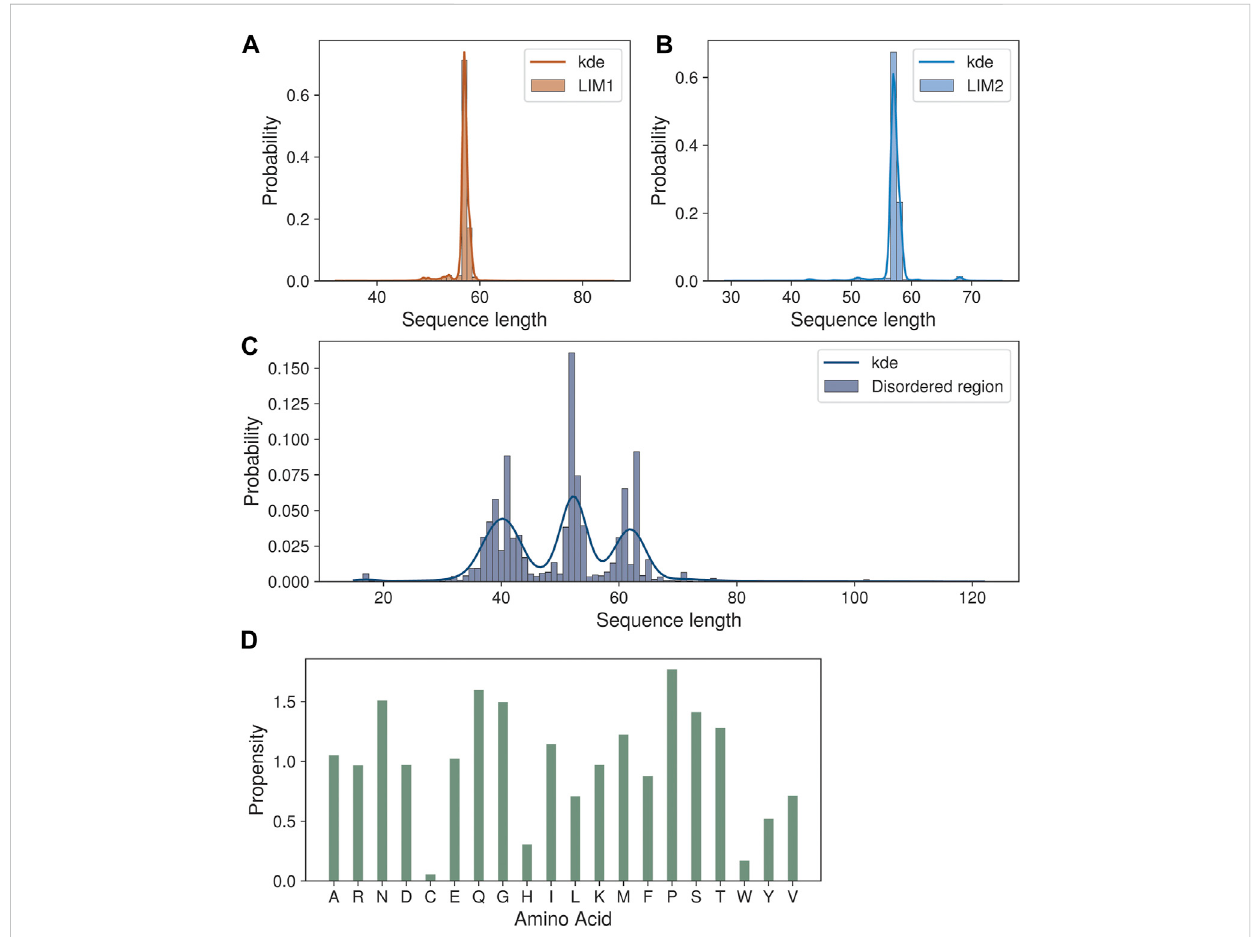
FIGURE 2 Sequence length variations in the CSRP3 homologs. (A,B) Histogram showing the length variation in LIM1 and LIM2 domains. (C) Trimodal distribution of disordered region length variation seen in the histogram plot. (D) Barplot highlighting the amino acid propensity in the disordered region.